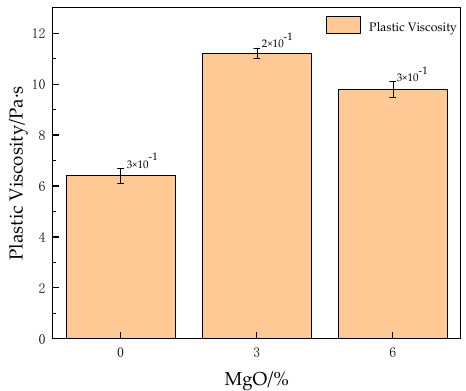
Figure 7. Plastic viscosity of the fresh paste.